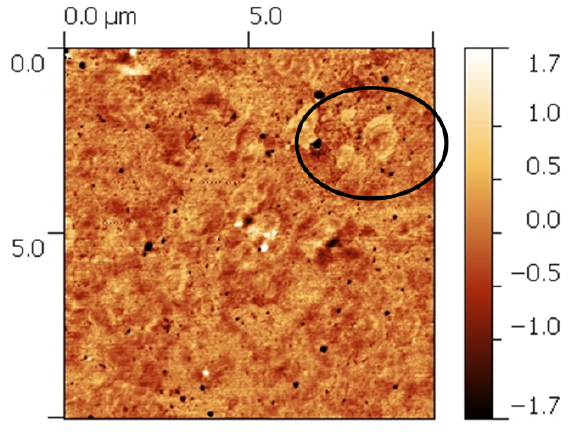
Figure 4. Height (a) and phase (b) contrast pictures as recorded by AFM of the binder part of the asphalt sample under investigation. The phase contrast image shows clearly the presence of crystals with bees inside in the circles (peri phase) within a continuum of perpetuum phase [12].